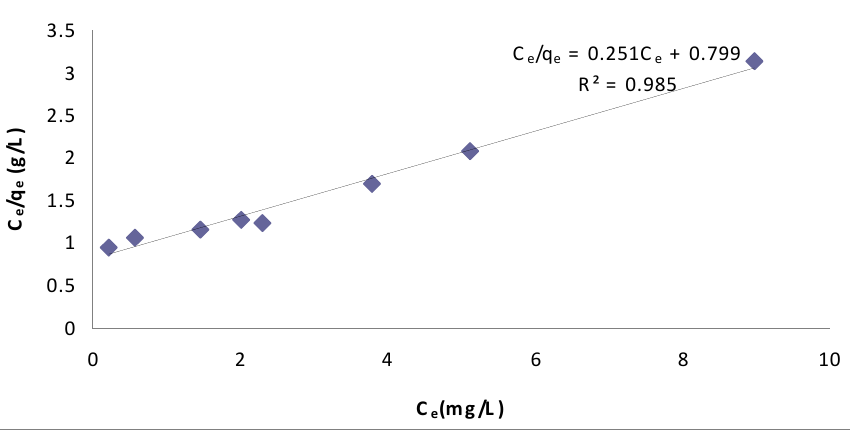
C e /q e = 0.251C e + 0.799 R² =